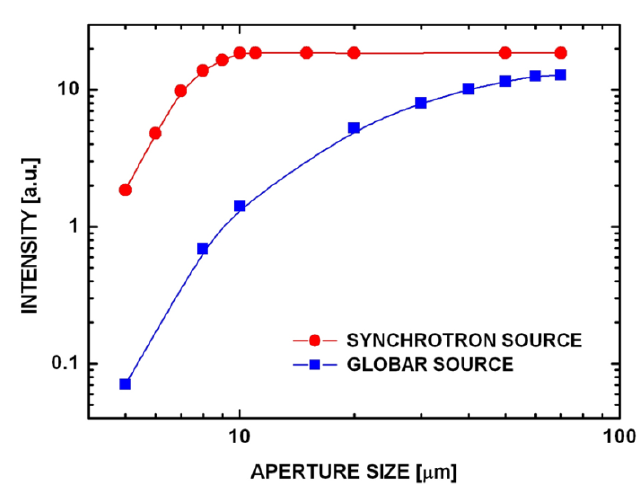
Figure 3: In the mid infrared range, more than one order of magnitude more flux can be fed through apertures smaller than 10 x 10 µ m 2 when compared to a globar source. This allows one to perform diffraction-limited microspectroscopy. Data were taken with a Nicolet Continuµm infrared microscope in confocal transmission geometry using the internal instrument aperture with no sample in the focal plane.